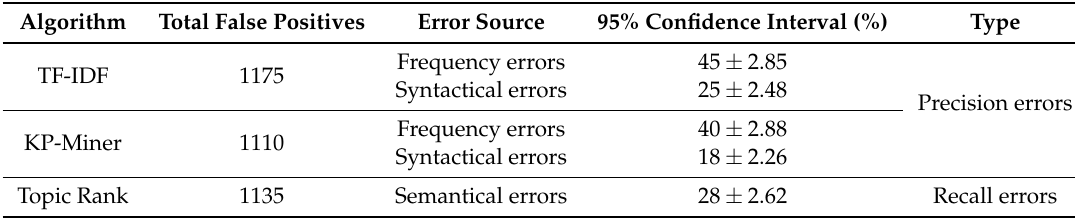
Table 7. Summary of the Error Source